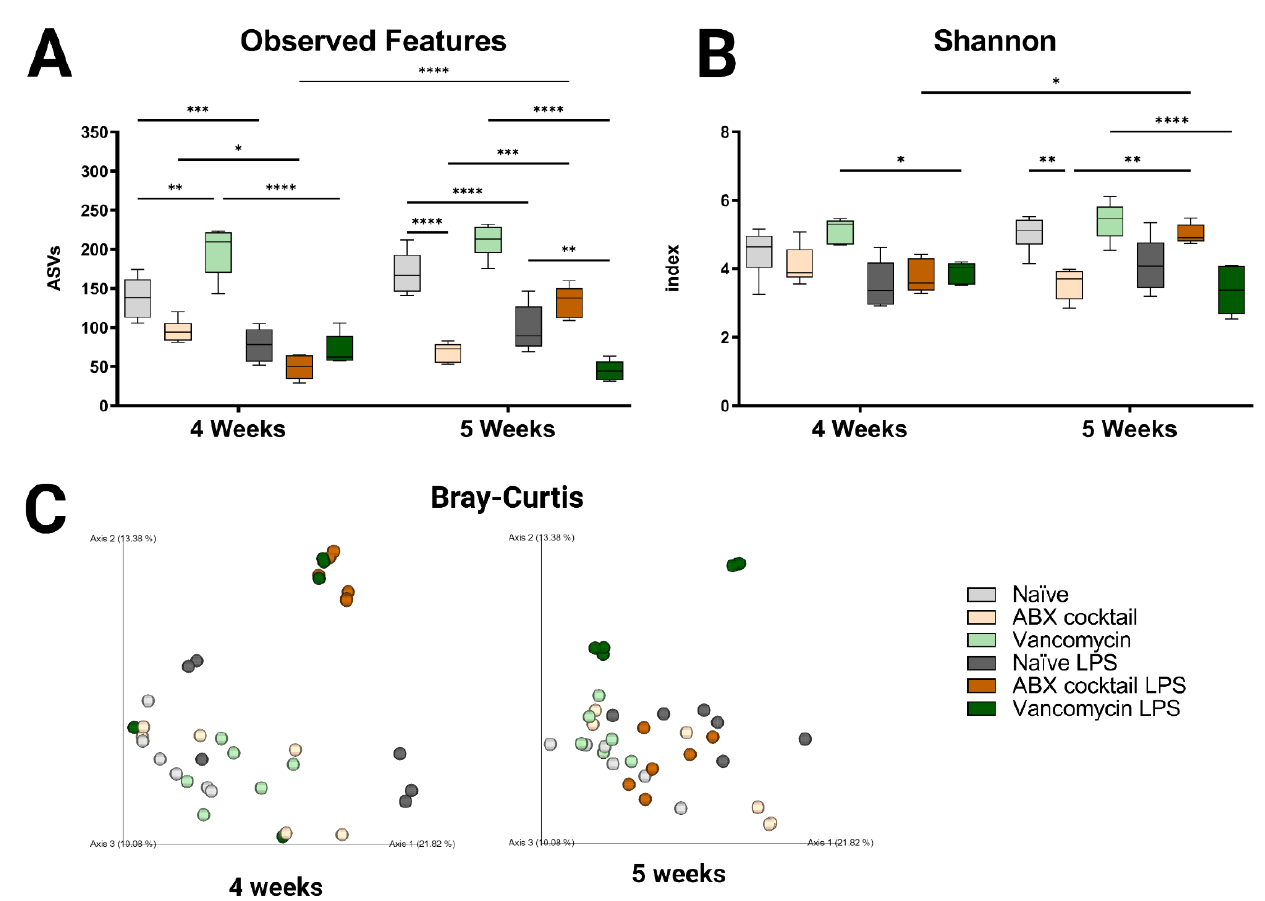
Figure 1. Prenatal ABX administration alters the gut microbiota diversity. ( A , B ) α -diversity measured using observed features and Shannon index ( C ) β -diversity indexes measured using principal coordinate analysis (PCoA) plot of Bray–Curtis dissimilarity between samples. Naïve = light grey, ABX cocktail = light brown, Vancomycin = light green, Naïve LPS = grey, ABX cocktail LPS = brown and Vancomycin LPS = green. n = 6 for all groups. Two-way ANOVA followed by Tukey post-correction test for multiple comparisons where values represent means ± SEM, * p ≤ 0.05, ** p ≤ 0.01, *** p ≤ 0.001 and **** p ≤ 0.0001.